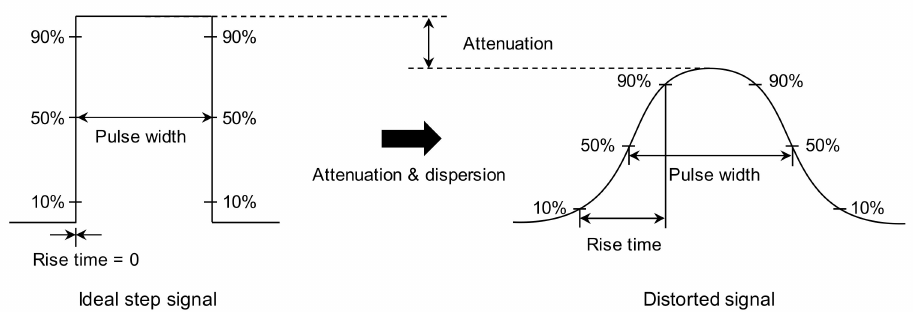
Figure 4. Signal distortion in lossy